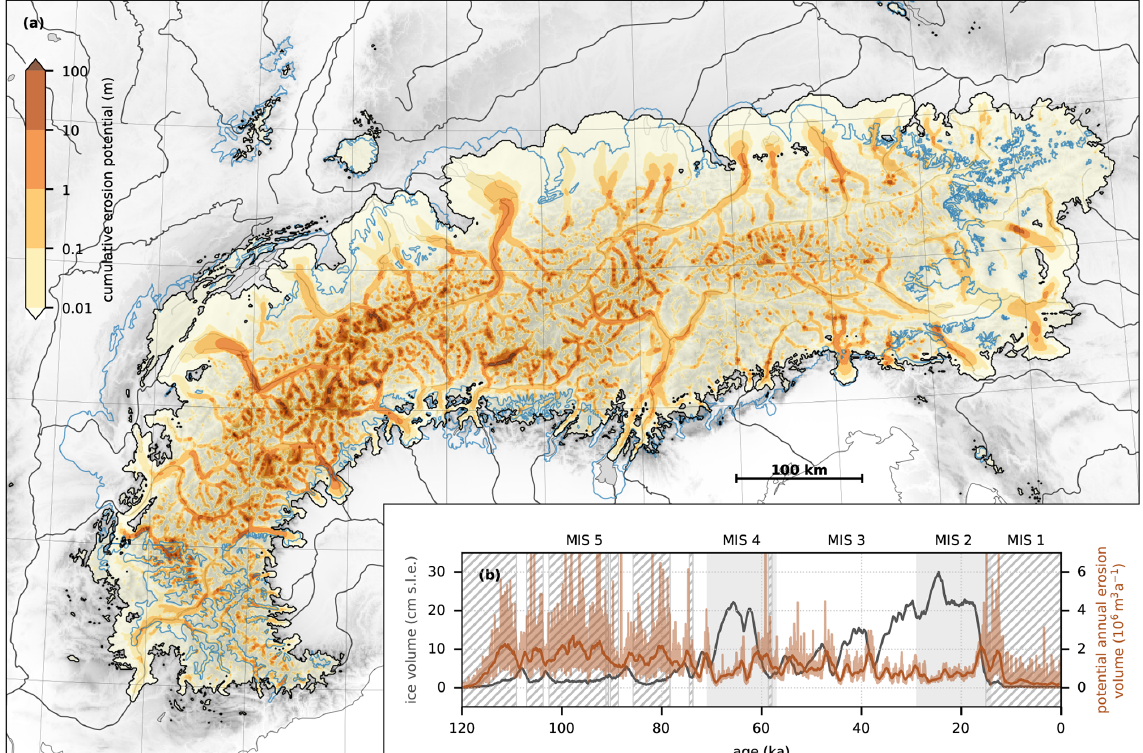
Figure 1. (a) Modelled cumulative (time-integrated) glacial erosion potential over the last glacial cycle and geomorphological reconstruction of Last Glacial Maximum Alpine glacier extent for comparison (solid blue line; Ehlers et al., 2011). The background map consists of the initial basal topography from SRTM (Jarvis et al., 2008) and Natural Earth data (Patterson and Kelso, 2017). (b) Modelled total ice volume in centimetres of sea-level equivalent (cms.l.e., black), annual (domain-integrated) potential erosion volume (light brown), and its 1ka running mean (dark brown). Shaded grey areas indicate the timing for MIS 2 (marine oxygen isotope stage) and 4 (Lisiecki and Raymo, 2005). Hatching marks periods with ice volume below 3cms.l.e. where glacier sliding may be affected by stress-balance approximations and the model horizontal resolution (see Sect.